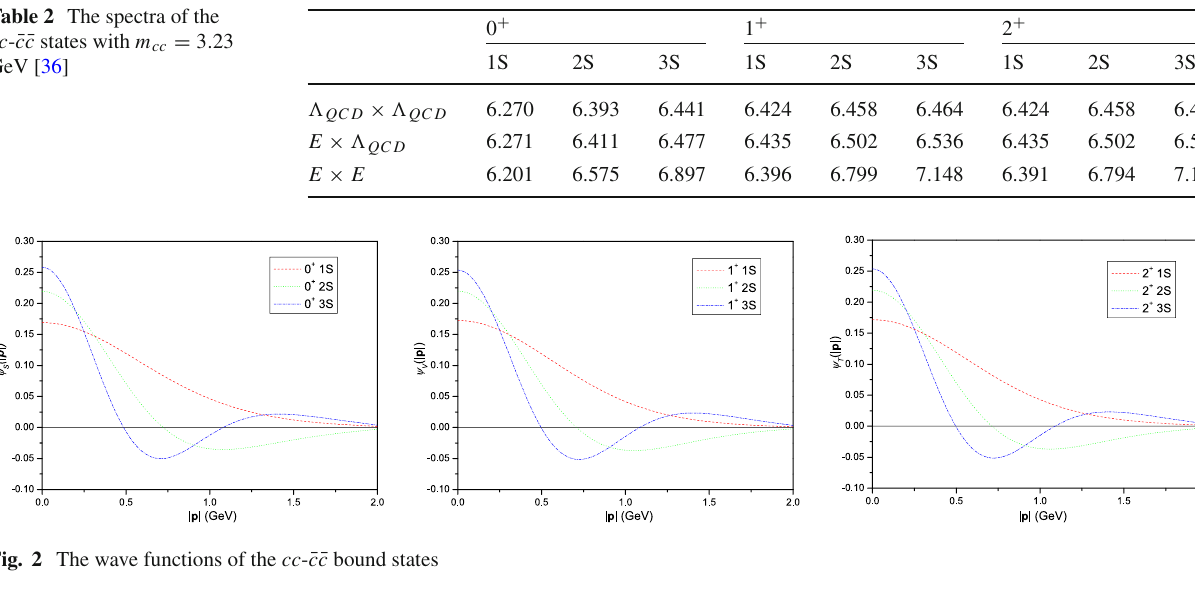
Fig. 2 The wave functions of the cc - ¯ c ¯ c bound states Table 3 The spectra of the cc - ¯ c ¯ c states in different